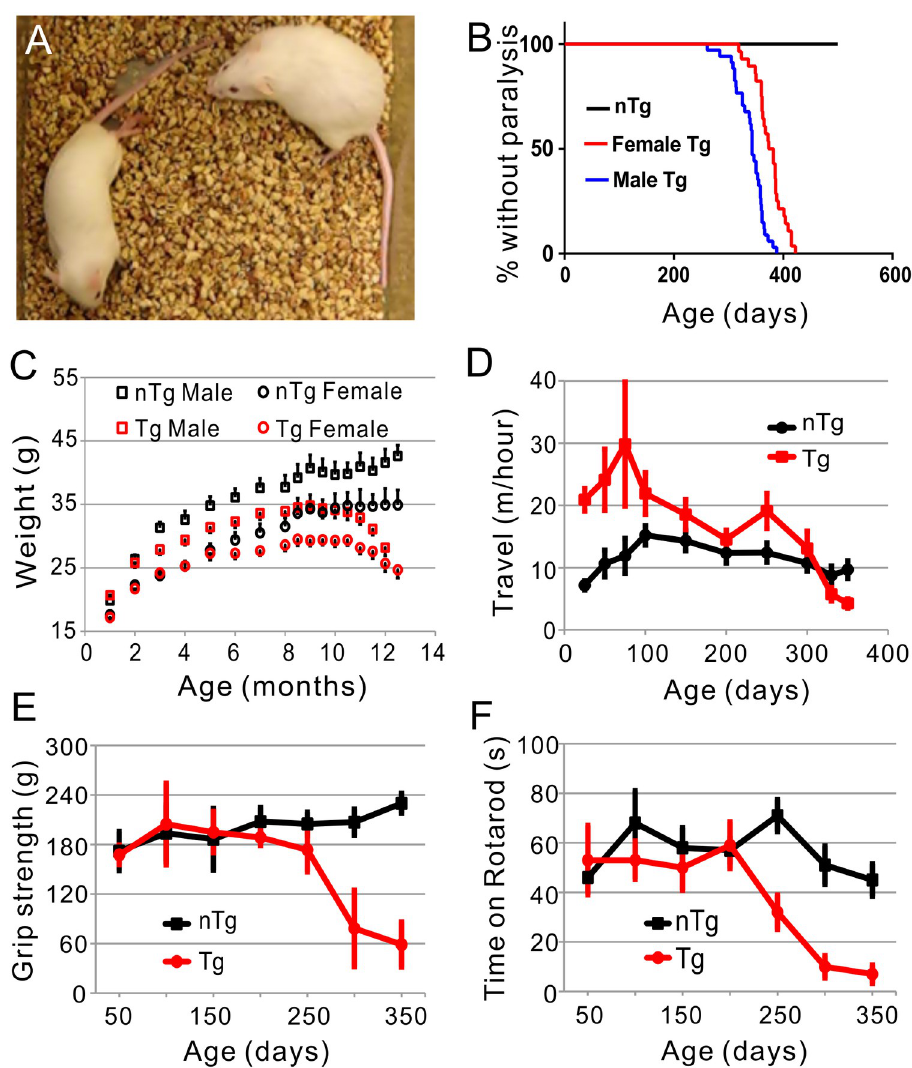
Fig 1. The TDP-43 homozygous transgenic (Tg) mice developed progressive motor phenotypes. (A) An example of Tg mice with hind limb paralysis (left). The mouse on the right was a non-transgenic (nTg) control. (B) Kaplan-Meier plot of Tg mice (37 males and 30 females) that are not paralyzed. (C) The bodyweight of the Tg mice peaked at ~9 months of age and then declined until the paralysis stage. The values were averaged from 10 to 21 animals per group per time point. (D) The home cage average travel velocity within a 24-hour period at various ages. The Tg mice went through a hyperactive stage before developing weakness and paralysis. (E) The Tg mice developed progressively weaker 4-limb grip strength after 250 days of age. (F) The Tg mice showed a declining rotarod performance after 200 days of age. Each data point in D, E, and F was an average of 16 animals.